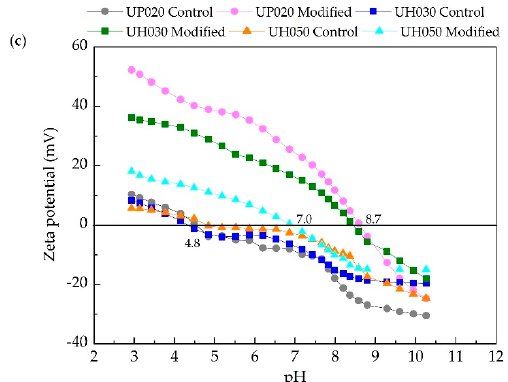
Figure 1. ( a ) ATR-FTIR spectra of the control and modified membranes. ( b ) Polymeric mass deposited on modified membranes with DA and PEI concentrations of 2 mg mL − 1 and a deposition time of 12 h. Bars with different letters show the statistical difference ( p < 0.05). ( c ) Zeta potential of control and modified membrane with DA and PEI concentrations of 2 mg mL − 1 and deposition time of 12 h.